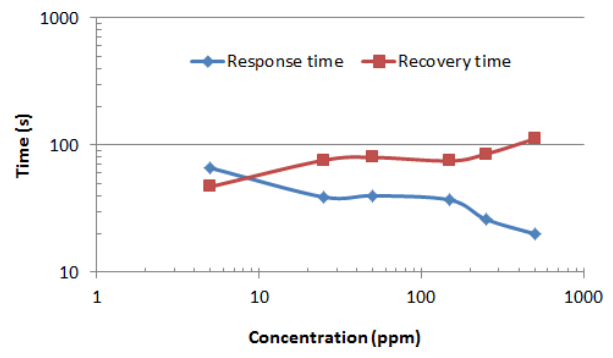
Figure 11. Dependence of response and recovery times of MWCNTs/SnO 2 DMF vapor sensor on gas concentration measured at 200 ◦ C operating temperature.